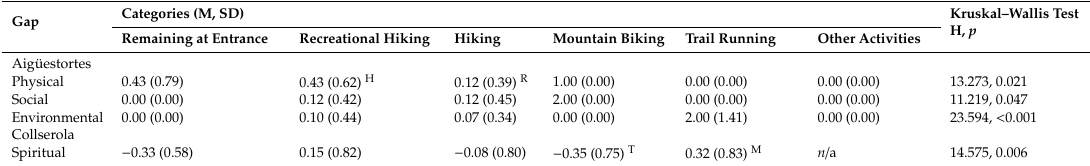
Table A4. Post hoc comparisons for the GAPs between expected benefits and satisfaction according to activity.